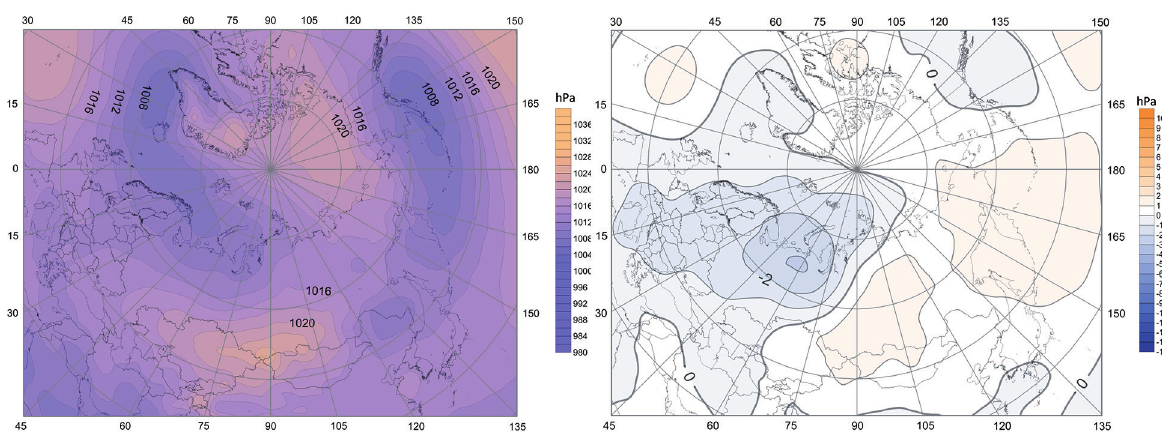
Fig. 7. Mean SLP (left) and anomalies (right) during the days with intensive snowmelt, ie, with snow cover decreases by at least 5 cm in at least two